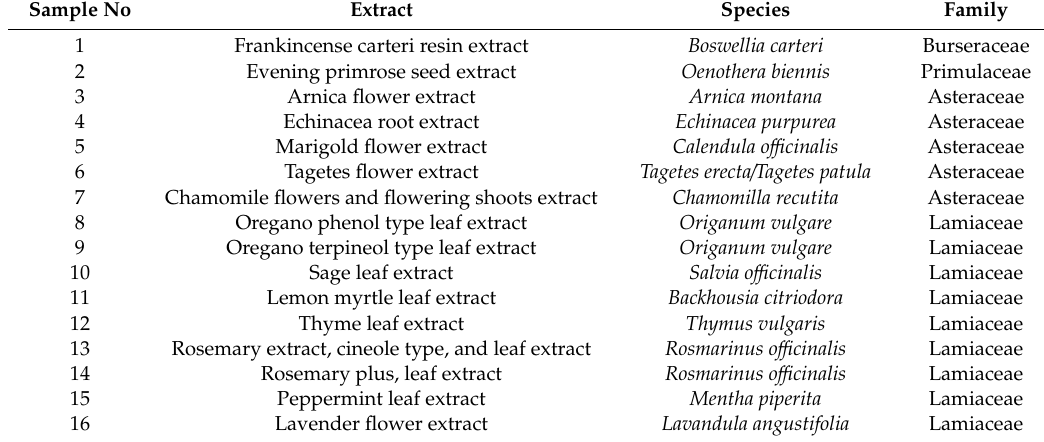
Table 1. Concentrated essential oils obtained by supercritical fluid extraction (FLAVEX ®